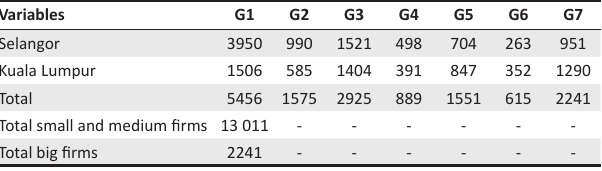
TABLE 2: Analysis of variance results among small, medium and large companies. Variables